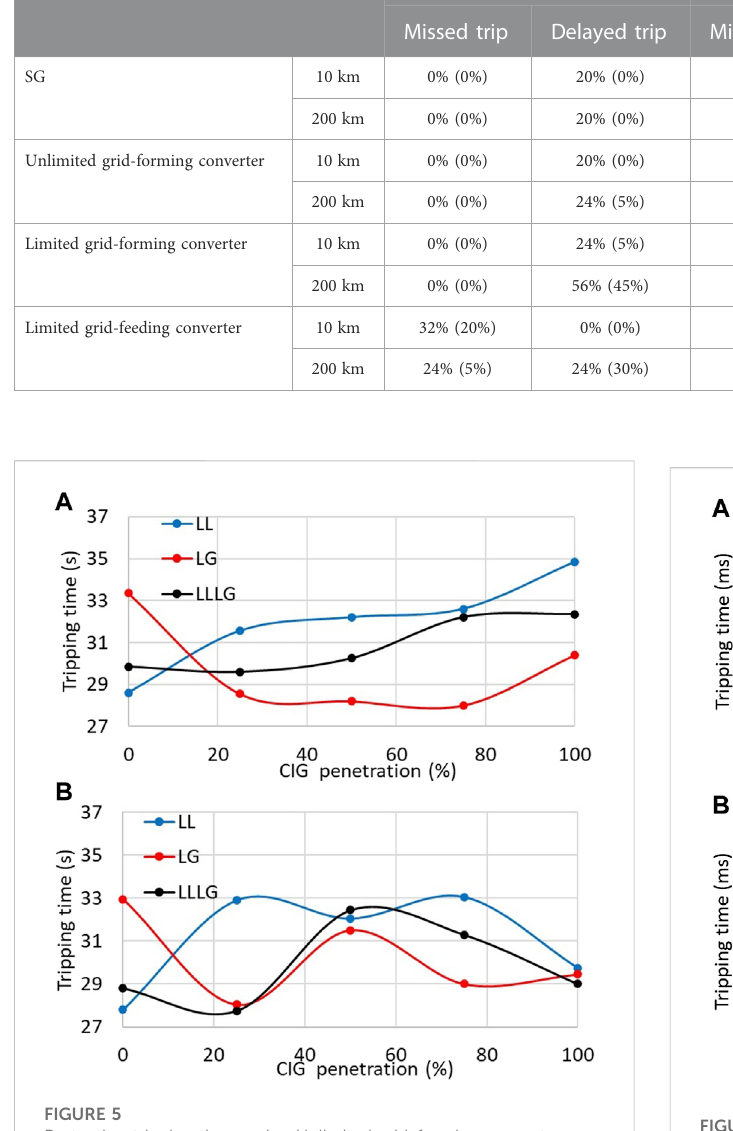
FIGURE 6 Protection tripping times using limited grid-forming converter with respect to CIG penetration increase. (A) Tripping time on 10 km transmission line; (B) Tripping time on 200 km transmission